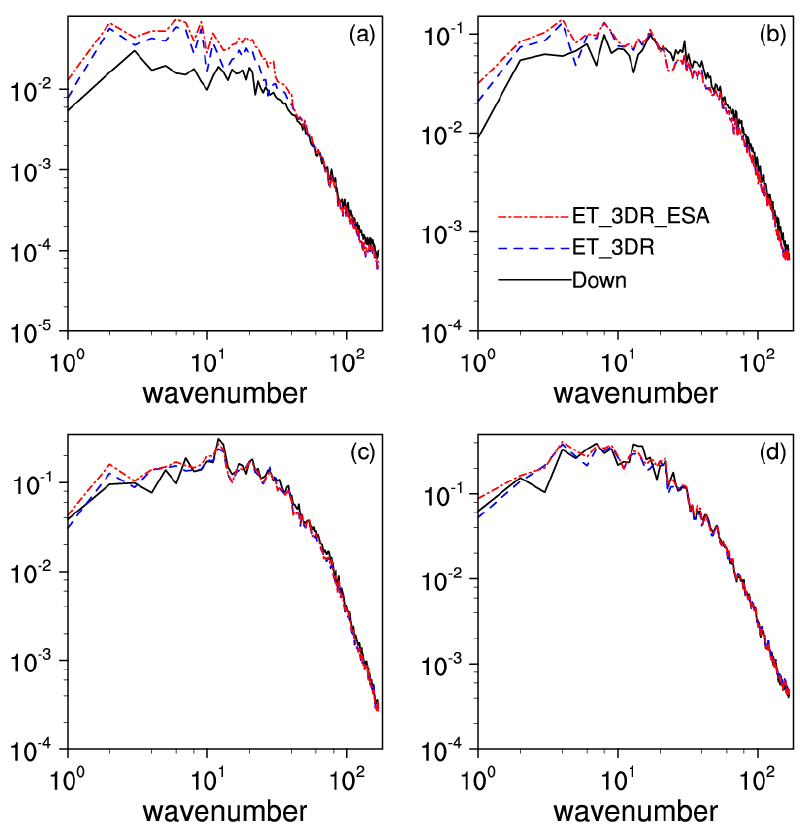
Figure 7. Power spectrum for 850-hPa total energy as a function of the wavenumber for the three ensemble forecast systems; ( a ) 3 h, ( b ) 6 h, ( c ) 9 h, and ( d ) 12 h.